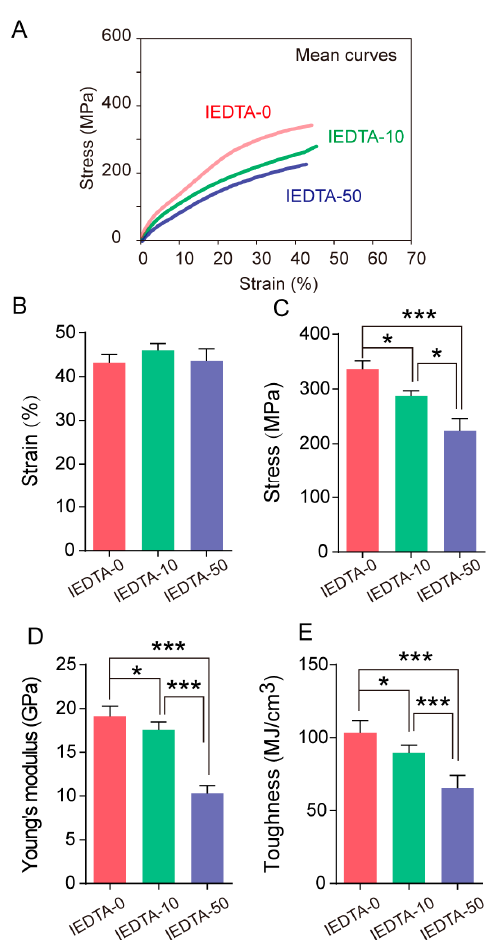
Figure 6. Effect of metal ions on the mechanical properties after injection. ( A ) Average stress-strain curves of each injected group; ( B ) Maximum strain; ( C ) Maximum stress; ( D ) Young’s modulus; ( E ) Toughness. Error bars, SD; * p < 0.05, *** p < 0.001 (One-way ANOVA).